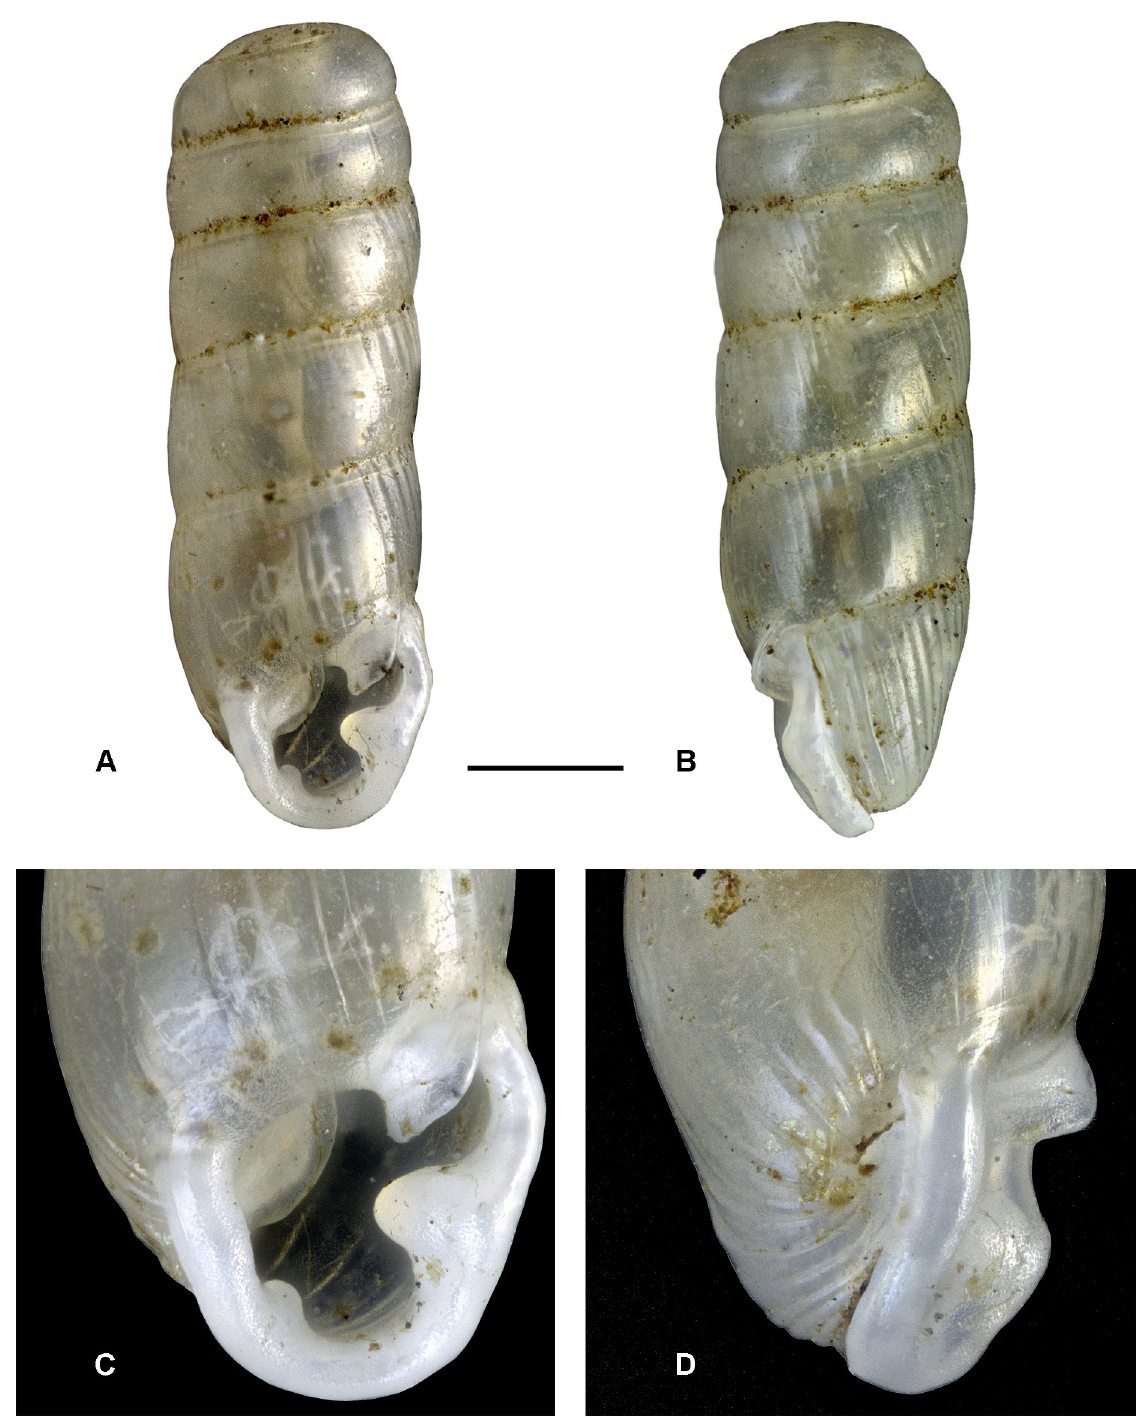
Fig. 9. Gulella abbotti sp. nov., holotype (NMSA W9602/T4522), length 2.55 mm, width 0.81 mm. A . Aperture view. B . Side view. C . View into aperture. D . Oblique view of base showing umbilicus. Scale bar = 0.5